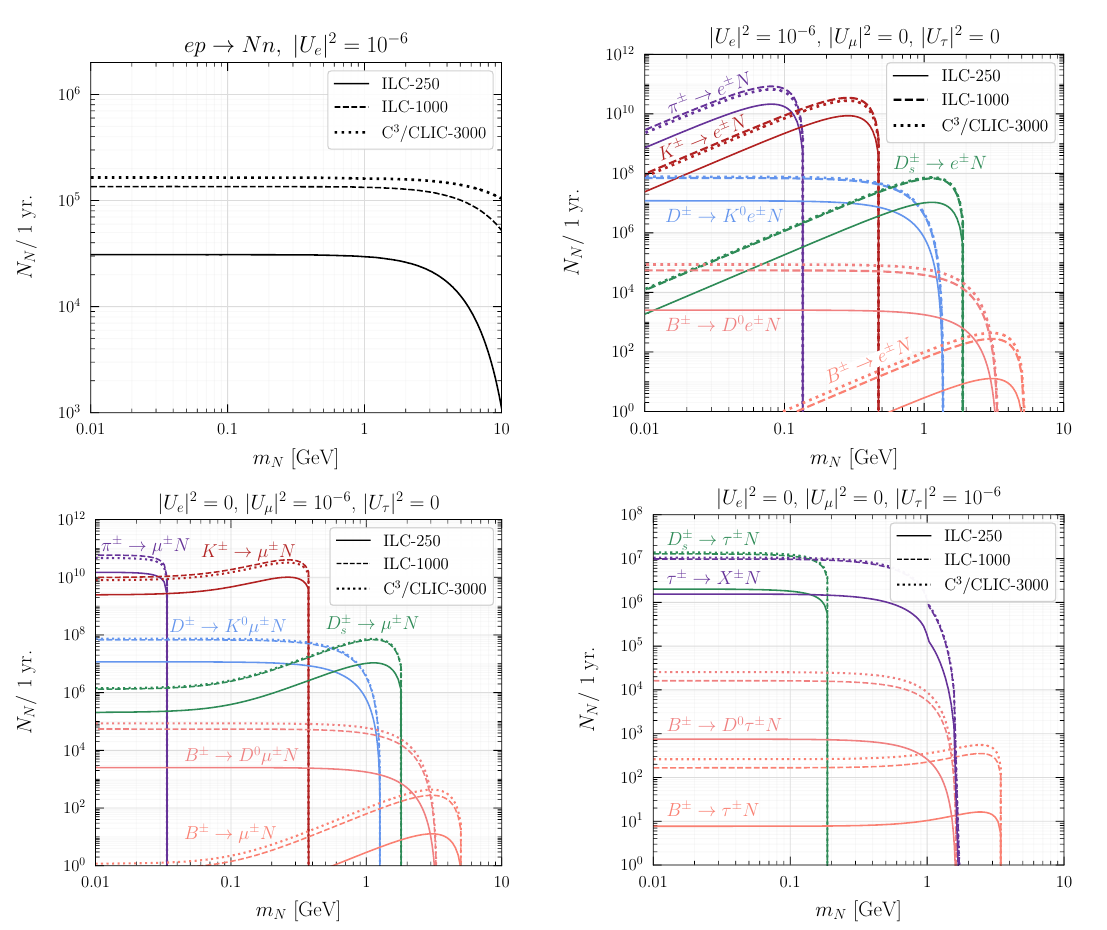
Figure 2 . Number of HNLs produced per year at the several experiments, having fixed a mixing angle | U 2 = 10 − 6 . Top left: number of electron-mixed HNLs produced from charged-current i | electron-proton scattering. Top right: number of electron-mixed HNLs produced from the decays of mesons. Bottom: number of muon-mixed (left panel) and τ -mixed (right panel) HNLs produced from the decays of mesons and τ